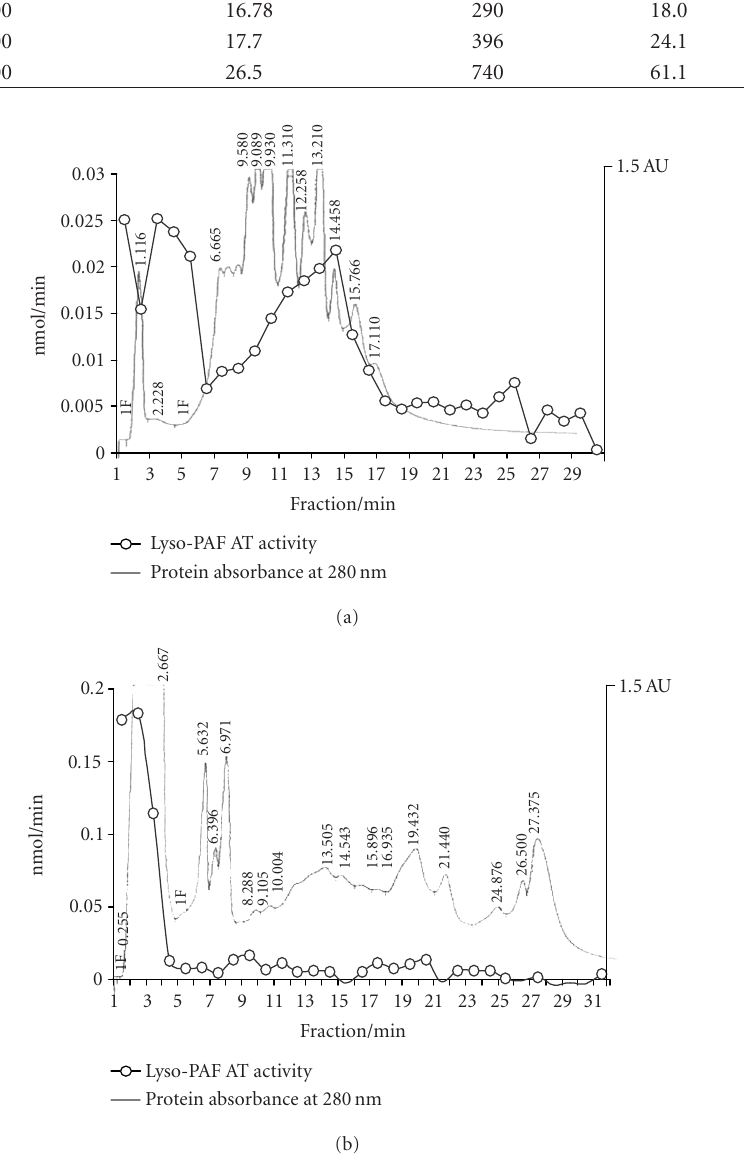
Figure 6. Ion exchange chromatography of solubilized fractions. Typical chromatographic purification and activities of lyso-PAF AT on fractions of (a) solubilized fractions of human kidney tissue and (b) solubilized fractions of